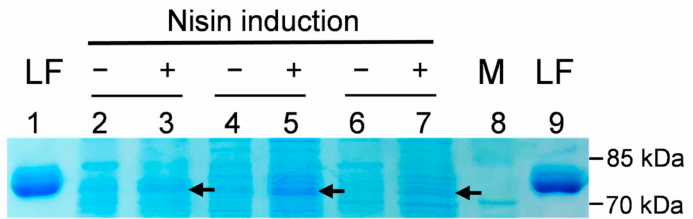
Figure 2. SDS-PAGE profile of recombinant lactoferrin expression. Probiotic hosts with porcine or bovine lactoferrin expression plasmids were induced (+) or non-induced ( − ) by lactoferrin expression using nisin for 4 h. Cells lysates were supernatant after sonication disruption and were analyzed via SDS-PAGE. LF: standard control panel, 0.32 µ g purified LF; M: molecular weight marker; lane 2 to 3: Lactobacillus delbrueckii/PLF ; lane 4 to 5: Lactobacillus gasseri/BLF ; lane 6 to 7: Bifidobacterium angulatum/PLF. Arrow indicates target lactoferrin with a molecular weight of about 80 kDa.